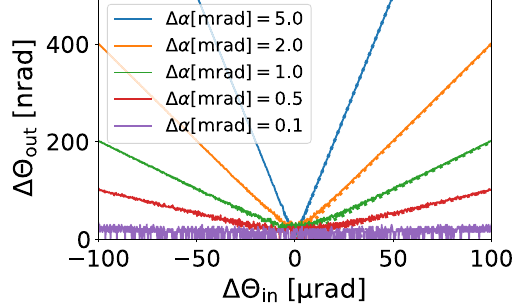
10. Influence of the diadic error on the retroreflector compensation. The solid lines correspond to numerical vector analysis, where the orientation of the crystal mirror was tuned such that the beam k 0 coinciding with the undulator axis gets reflected back to itself after total reflection and would make an angle of Θ i ¼ 3 . 1 mrad with both total reflecting mirrors after reflection at the crystal for the case of Δ α ¼ 0 . The dashed lines correspond to the approximation (B2). The agreement is good, except for Δ α ¼ 0 . 1 mrad, where the numeric results becomes very noisy due to rounding